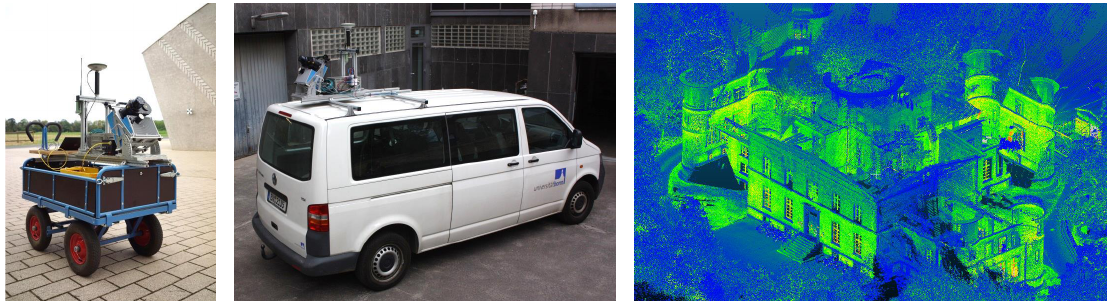
Figure 1. Mobile laser scanning system of the University of Bonn adapted to a trolley ( left ) or a van ( middle ). The 3D point cloud ( right ) was recorded during a mapping campaign in Bonn,